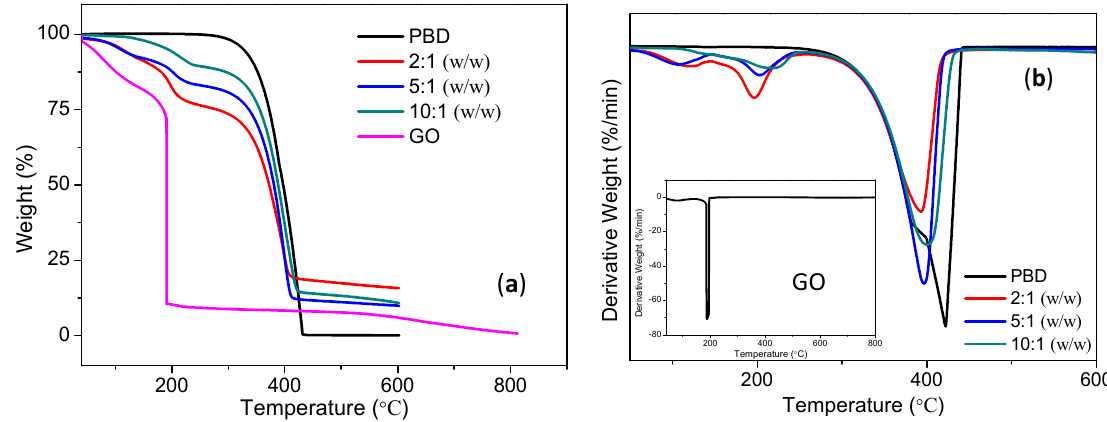
Figure 6. Characterization of GO, PBD:GO nanocomposite, PBD. ( a ) Thermo gravimetric analysis (TGA) and ( b ) differential thermo-gravimetric (DTG) properties of GO (in Inset), PBD:GO nanocomposites with 2:1, 5:1, and 10:1 (w/w), and